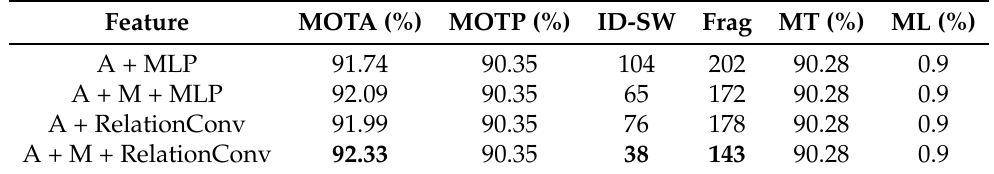
Table 4. Effectiveness of appearance feature (A), motion feature (M), and different convolu- tional operation.